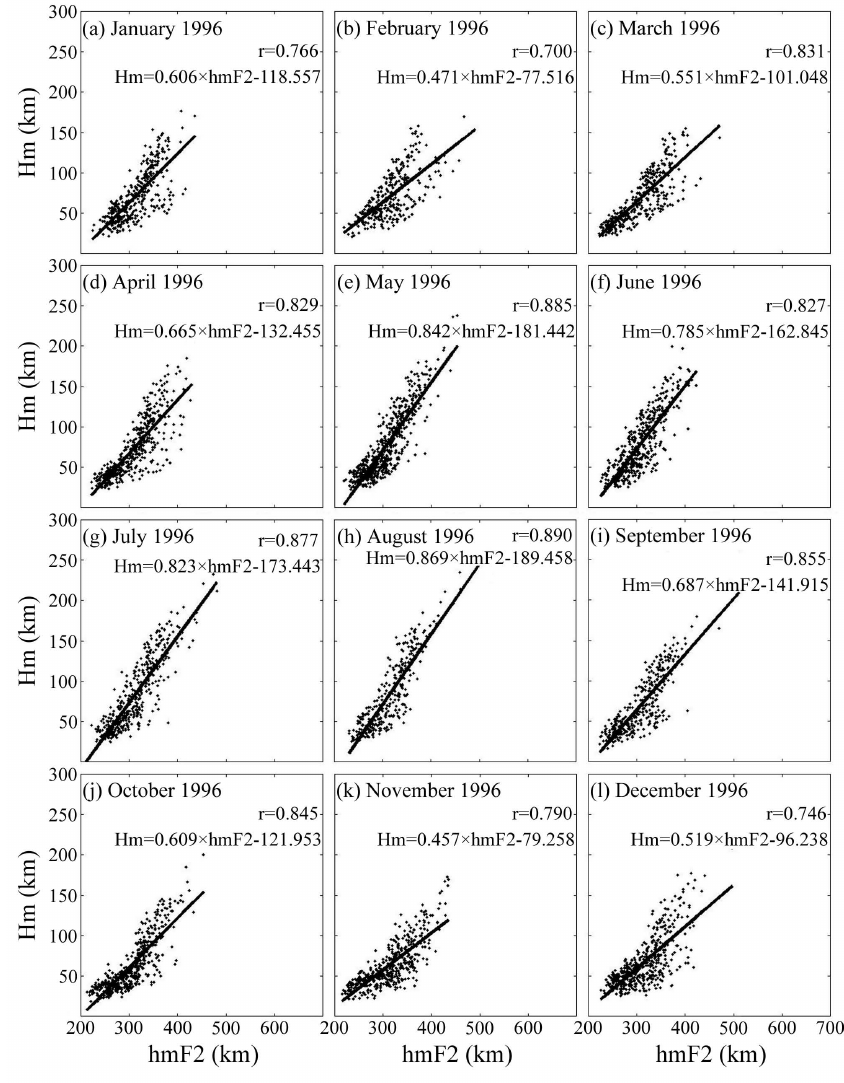
Fig. 6. The scatter plots of Hm versus hmF2 during January–December 1996. The correlation coefficient ( r ) of Hm and hmF2 and the equation of least-squares straight line (solid line) for each month are placed in the upper-right